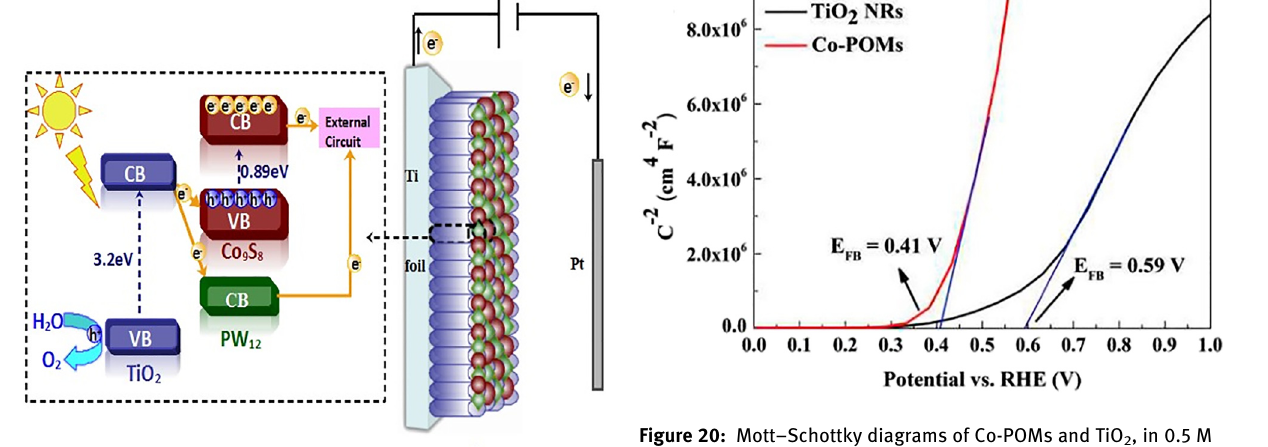
Figure 20: Mott – Schottky diagrams of Co-POMs and TiO 2 , in 0.5 M Na 2 SO 4 (pH) 7.4 three-electrode system under 300 W Xe-lamp with AM 1.5G fi lter (100 mW cm − 2 ). Adopted with permission from ref.